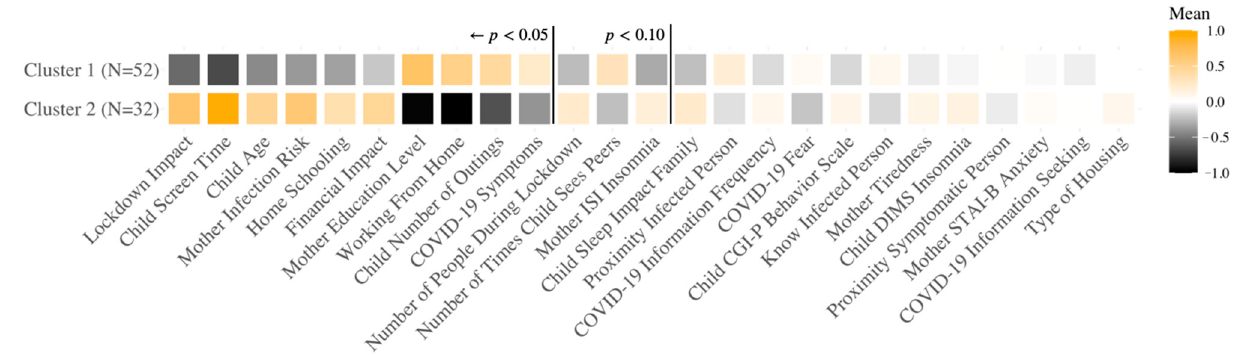
Figure 2. Hierarchical clustering analysis results for the Swiss sample. Each square represents the average value of the corresponding variable (transformed Yeo-Johnson) [70]. Brighter colors indicate high values while blacker colors indicate low values. The variables are ordered based on the most significantly different, positively, between the clusters, then negatively, then the non-significant differences. Variables to the left of the first vertical line are significantly different between the clusters. ISI: Insomnia Severity Index; CGI-P: Conners’ Global Index; DIMS: Difficulties Initiating and Maintaining Sleep; STAI-B: State Trait Anxiety Inventory form Y-B.